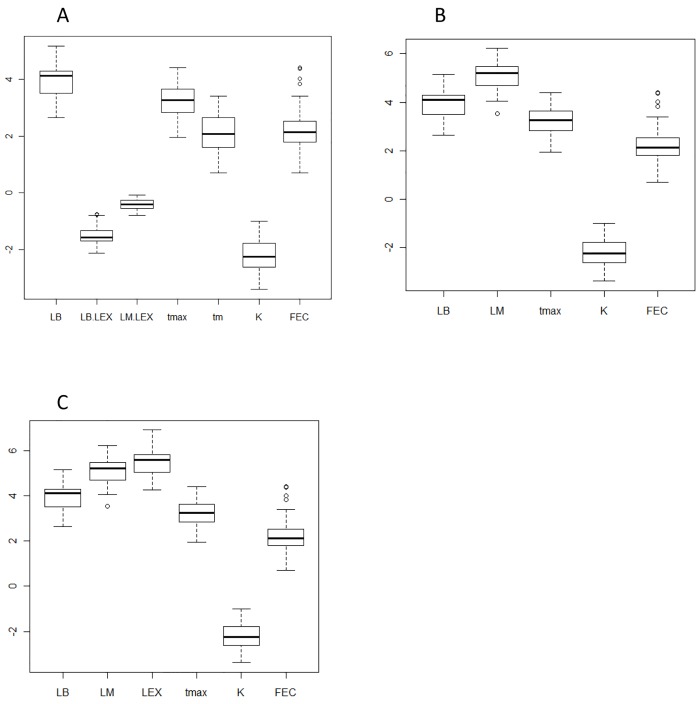
Box plot of vital parameters for Groups 1, 2, and 3.(Figs 3A, 3B, and 3C, respectively). Lb: size at birth, Lm: size at maturity, Linf: asymptotic length, Lb/ Linf: ratio of Lb and Linf, Tmax: maximum age, K: growth coefficient, f/RC: annual fecundity.